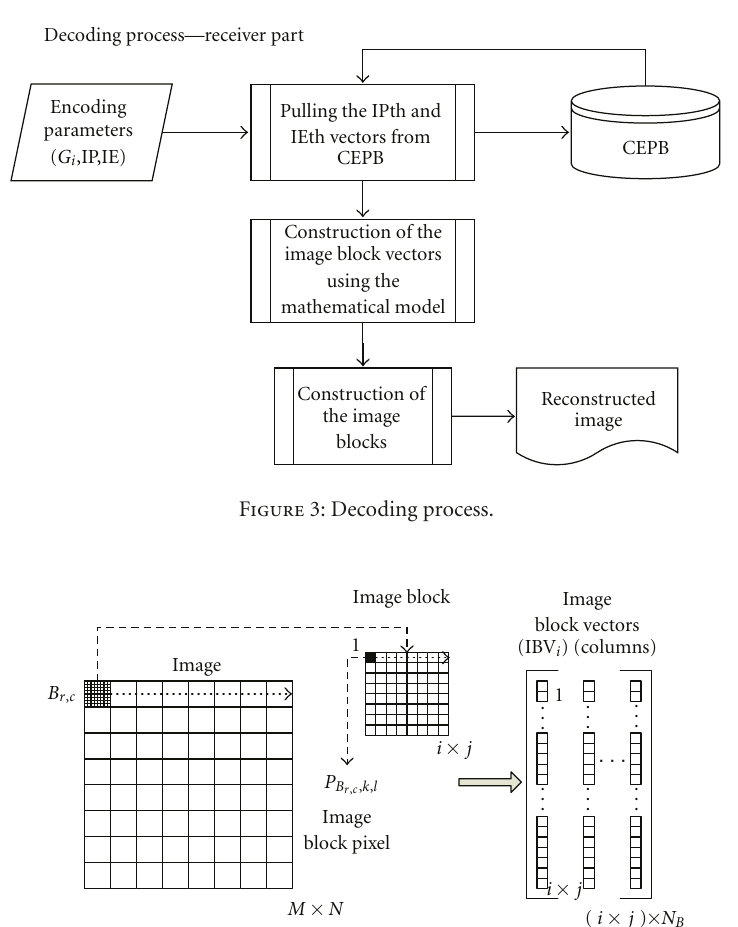
Figure 4: Partitioning of an image into the image blocks and reshaping as vector